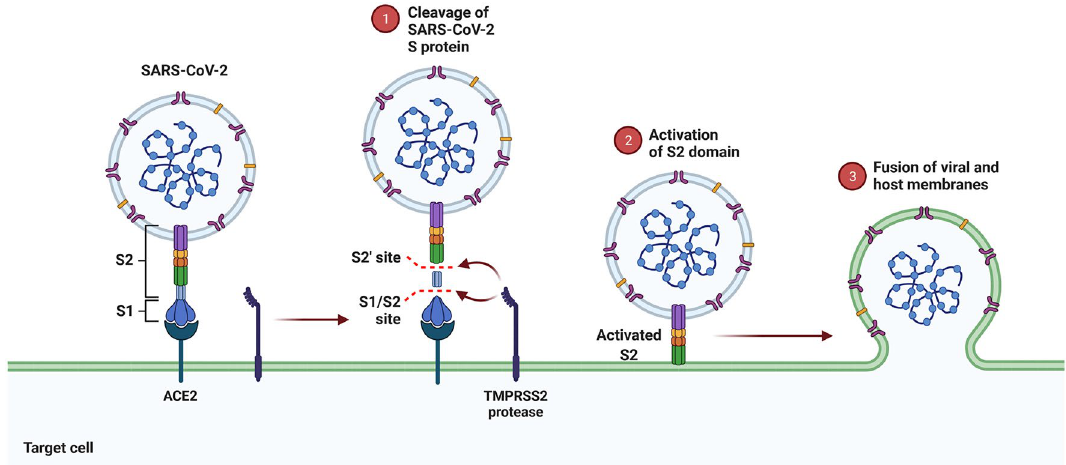
Figure 1. Mechanism of S protein action. (1) The cleavage of S protein to two parts, including S2 and S1 segments. (2) The step of S2 domain activation by binding the S protein to ACE2 receptor. (3) Fusion of viral with the target cell membrane. Reprinted from "Mechanism of SARS-CoV-2 Viral Entry", by BioRender, November 2020, retrieved from https:// app. biore nder. com/ biore nder- templ ates/ figur es/ 5e99f 5395f d61e0 02868 2c01/t- 5f99e b1307 ef9a0 09f1c 61e0- mecha nism- of- sars- cov-2- viral- entry Copyright 2022 by